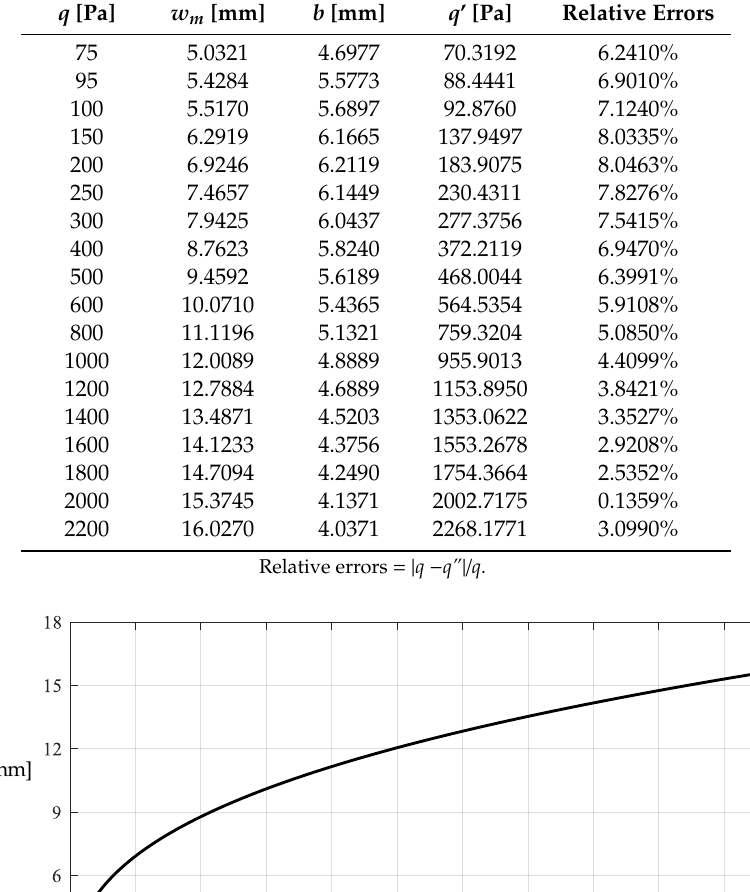
derived from Equation (54), is used to draw the dashed line. Table 2. The numerical results for k = 0.01 N / mm and (cid:52) l = 0.5 mm. Table 2. The numerical results for k = 0.01 N/mm and △ l = 0.5 mm.